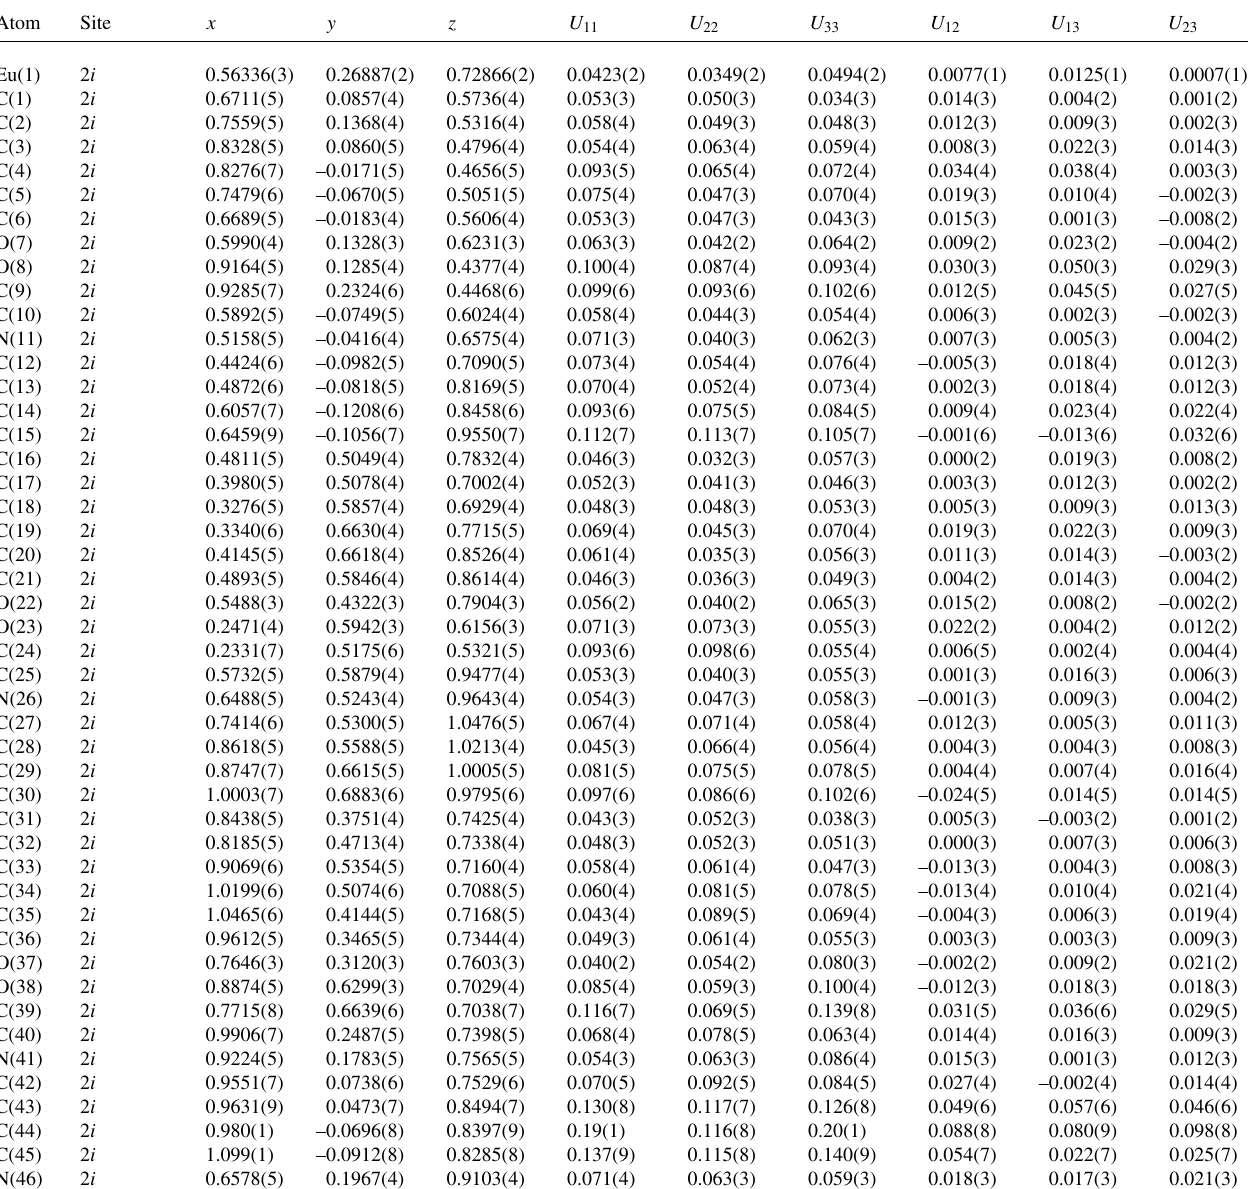
Table 3. Atomic coordinates and displacement parameters (in Å 2 )